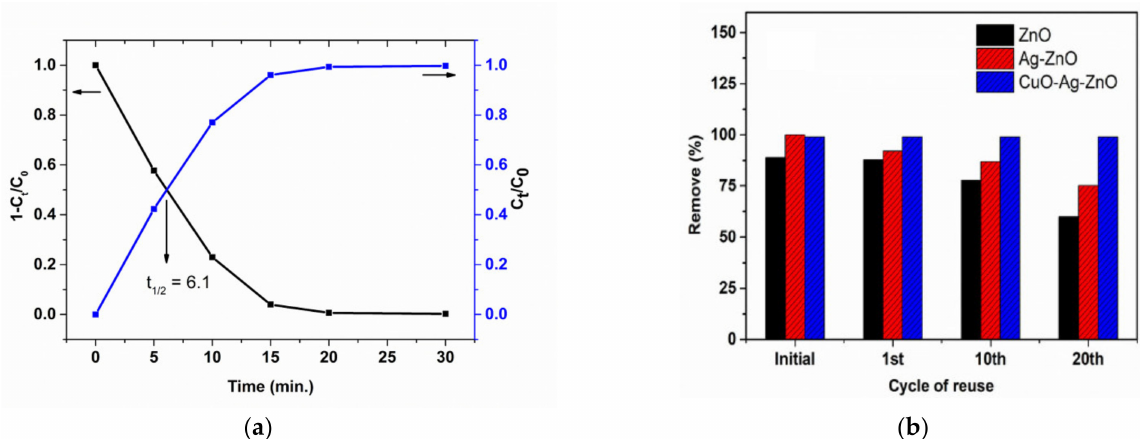
Figure 11. ( a ) Half-life estimation curve for degradation of MO dye using CuO-Ag–ZnO NWs, and ( b ) reuse studies of MO using ZnO, Ag-ZnO and